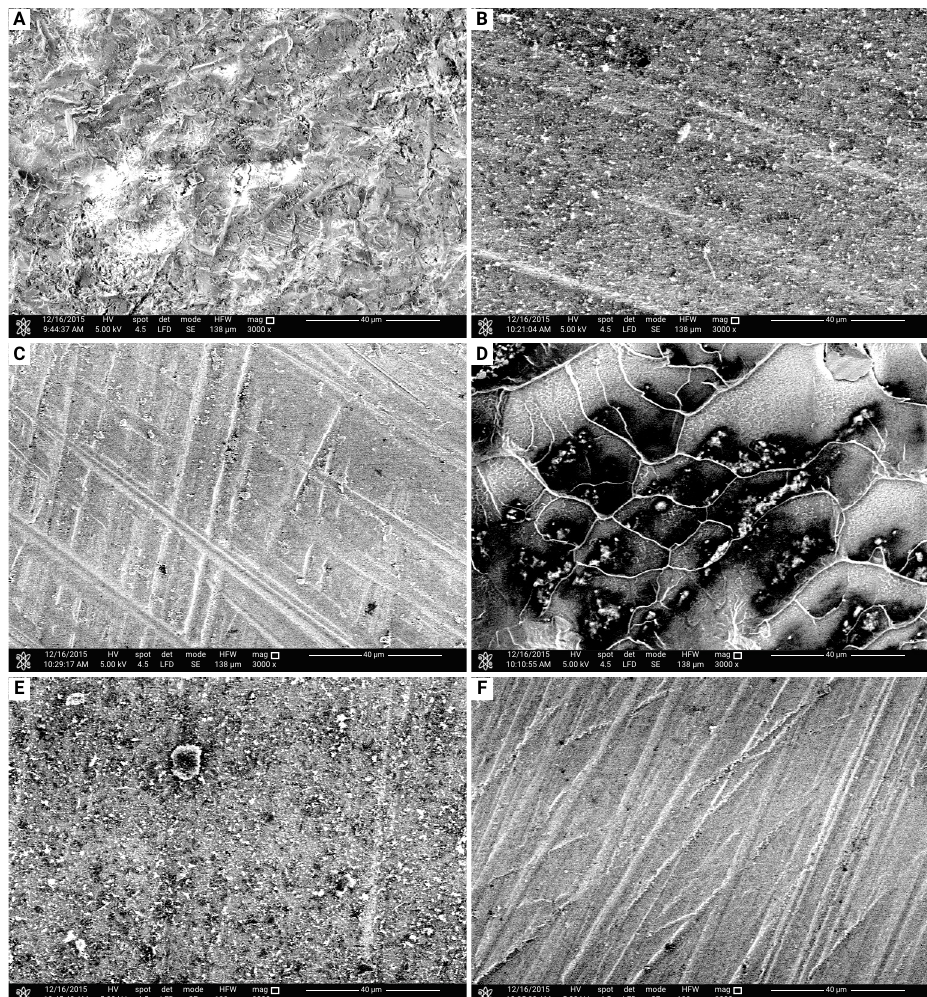
Figure 2. Scanning electron microscopy of treatments (3,000x magnification). 2A: sandblasting with 110 μm aluminum oxide. 2B: sandblasting with Rocatec Soft®. 2C: Er: YAG laser irradiation. 2D: Er: YAG laser irradiation plus sandblasting with aluminum oxide 110 μm. 2E: Er: YAG laser plus sandblasting with Rocatec Soft®. 2F: